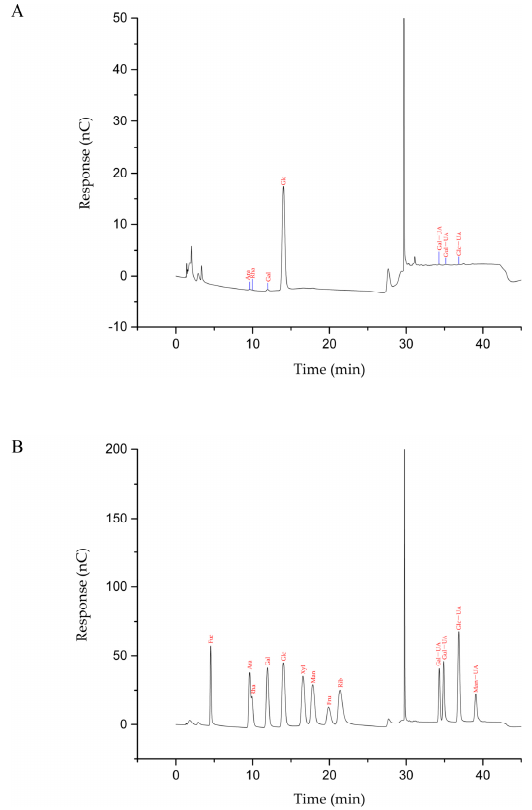
Figure 4. ( A ) The HPAEC chromatogram of cMORP; ( B ) the HPAEC chromatogram of monosaccha- ride standard. Table 5. Monosaccharide compositions of cMORP.